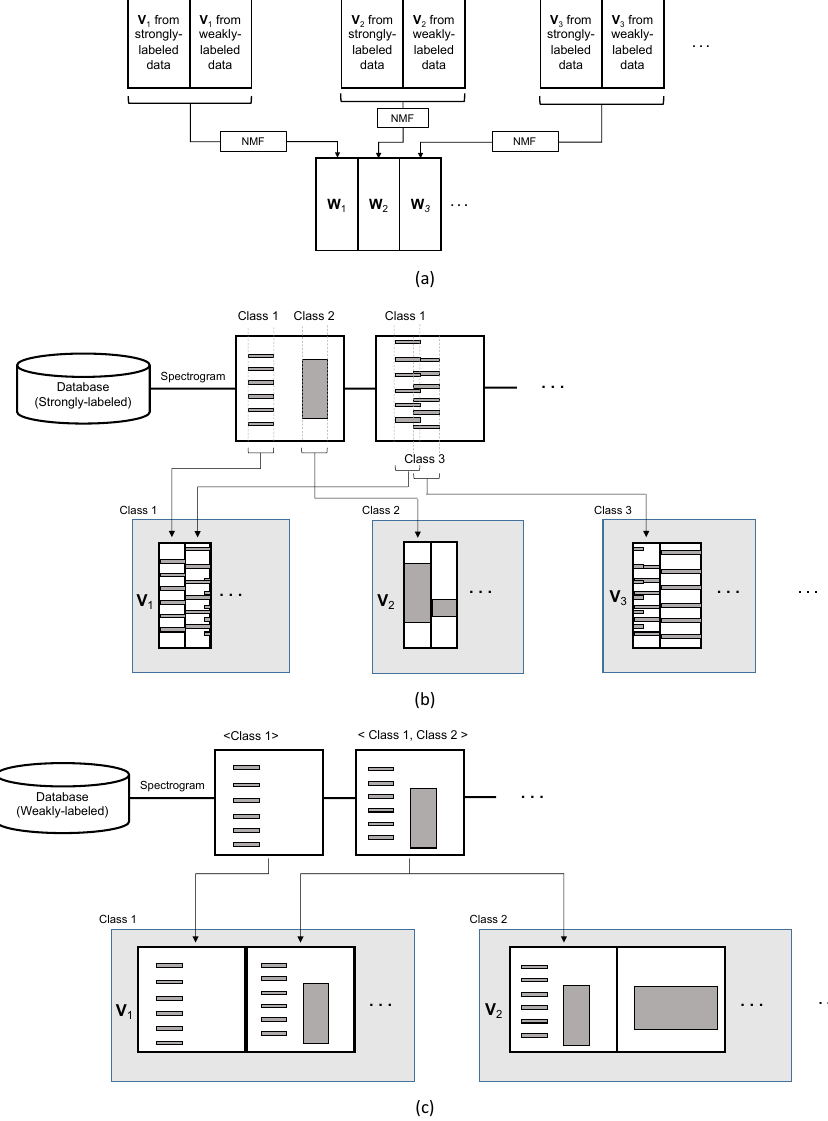
Figure 3. Block diagrams for: ( a ) the learning of the frequency basis; ( b ) the learning of the composi- tion of the data matrix from strongly-labeled data; and ( c ) the learning of the composition of the data matrix from weakly-labeled